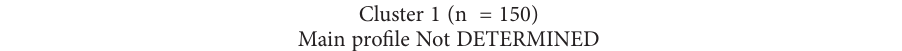
Table 4. Characterization of the clusters of the first level of pre-crisis chained cluster (source: own elaboration based on COMTRADE,